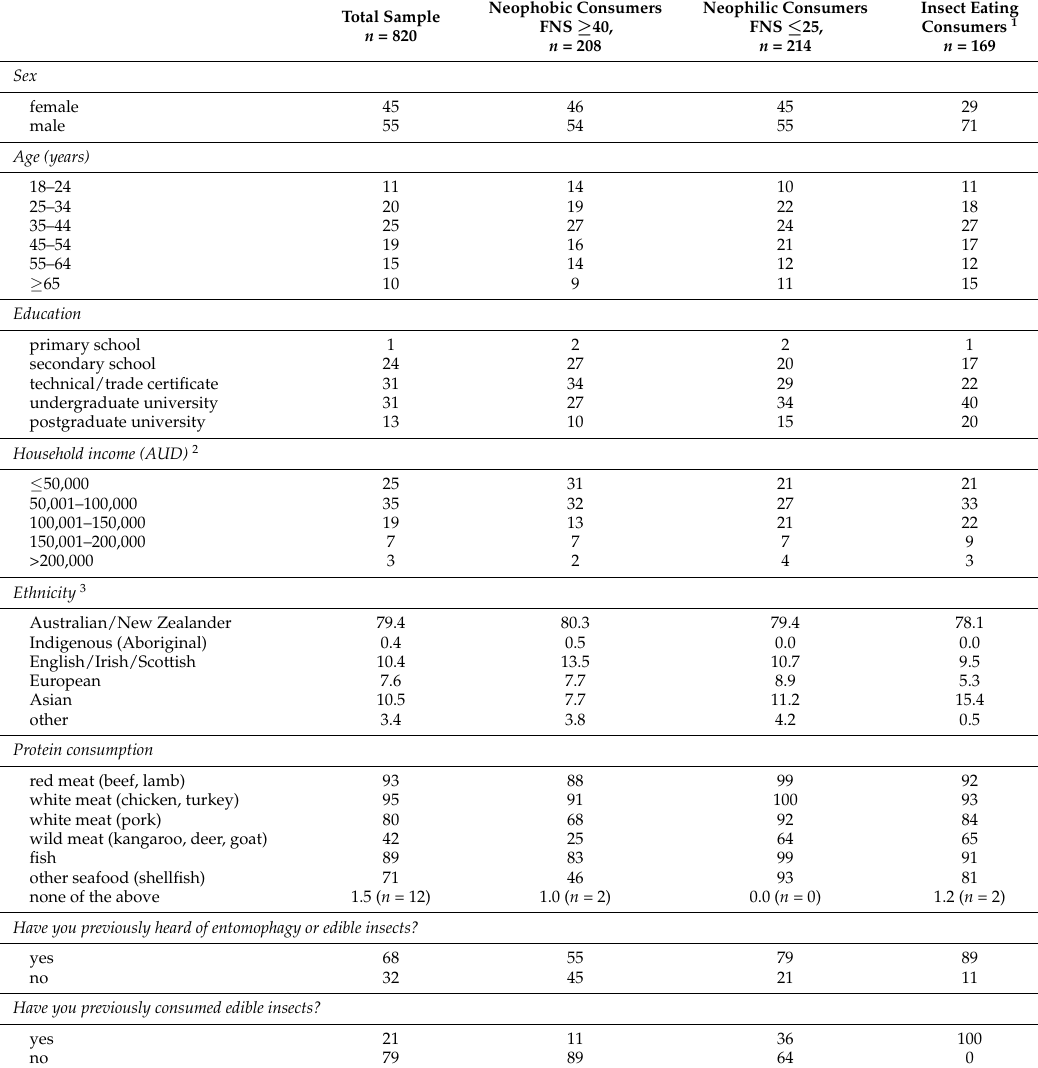
Table 1. Consumer demographics, awareness, and consumption of edible